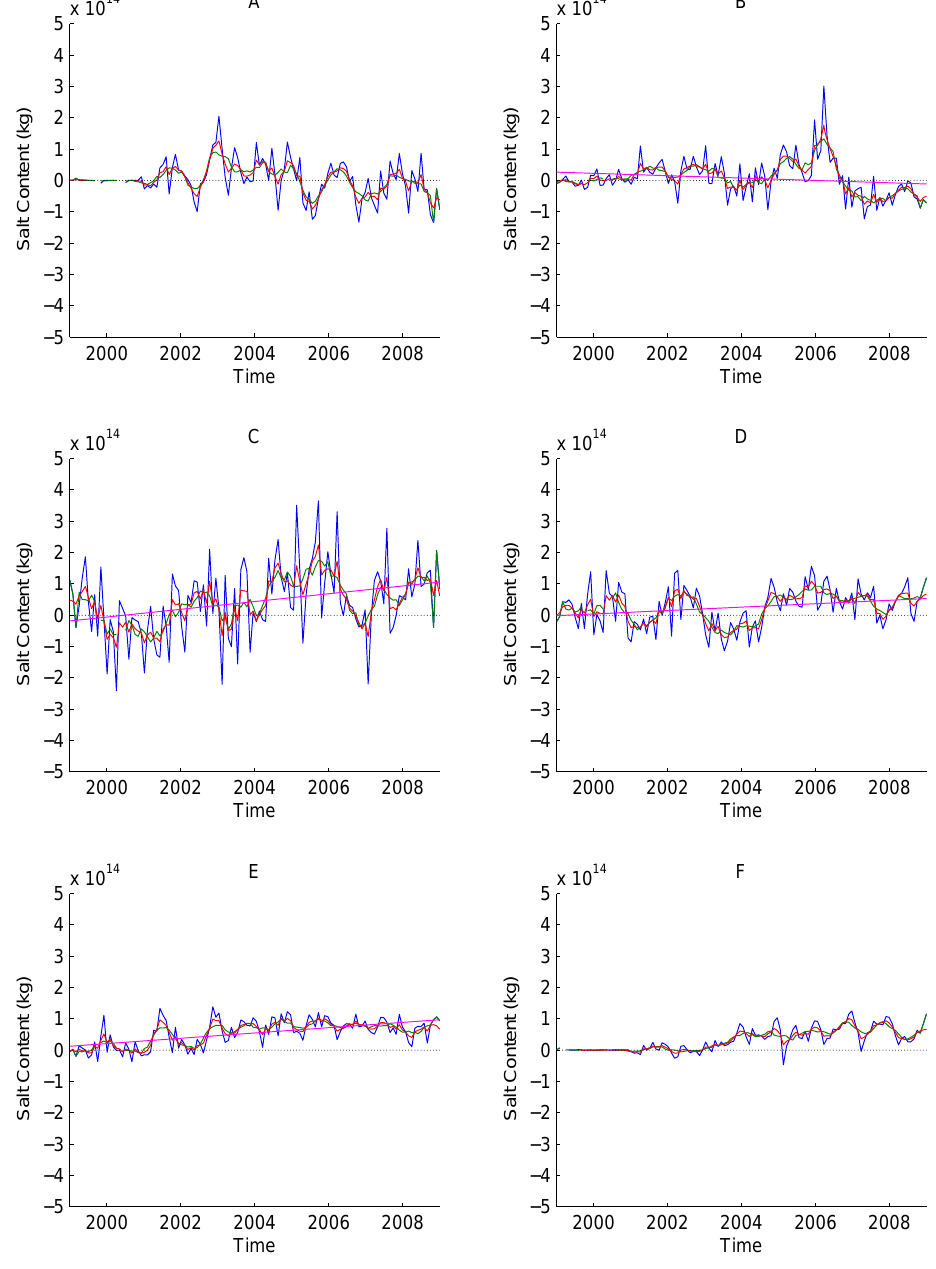
Fig. 12. Zonally integrated anomaly of salinity content of the upper 2000m for the 10 ◦ belts: (a) between 10 ◦ N and 20 ◦ N; (b) between 20 ◦ N and 30 ◦ N; (c) between 30 ◦ N and 40 ◦ N; (d) between 40 ◦ N and 50 ◦ N; (e) between 50 ◦ N and 60 ◦ N; (f) between 60 ◦ N and 70 ◦ N;